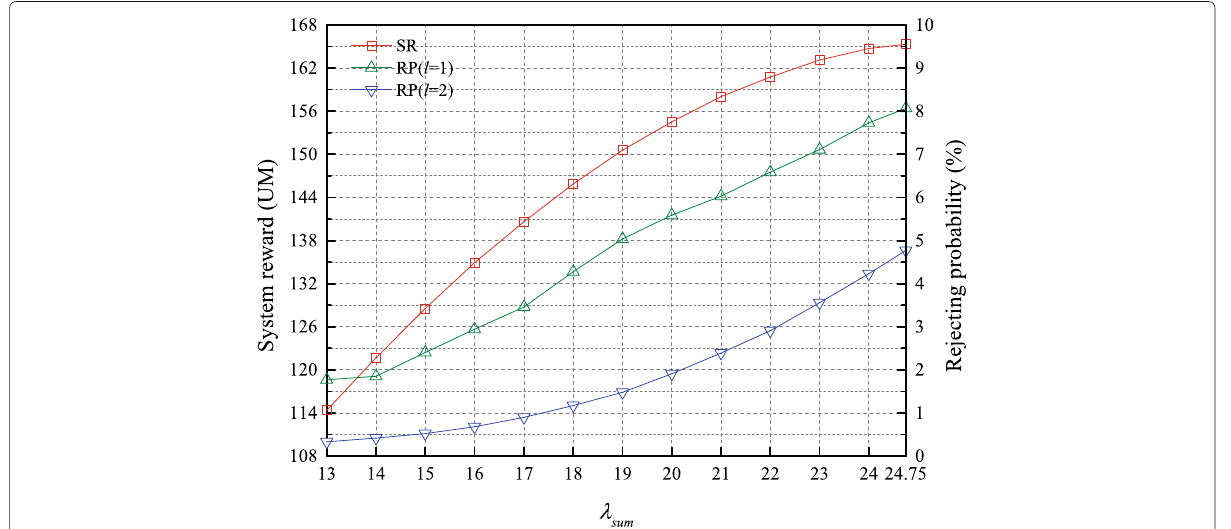
Fig. 6 SR and RPs under different task request arrival rates. This figure shows the evaluation results under different task request arrival rates